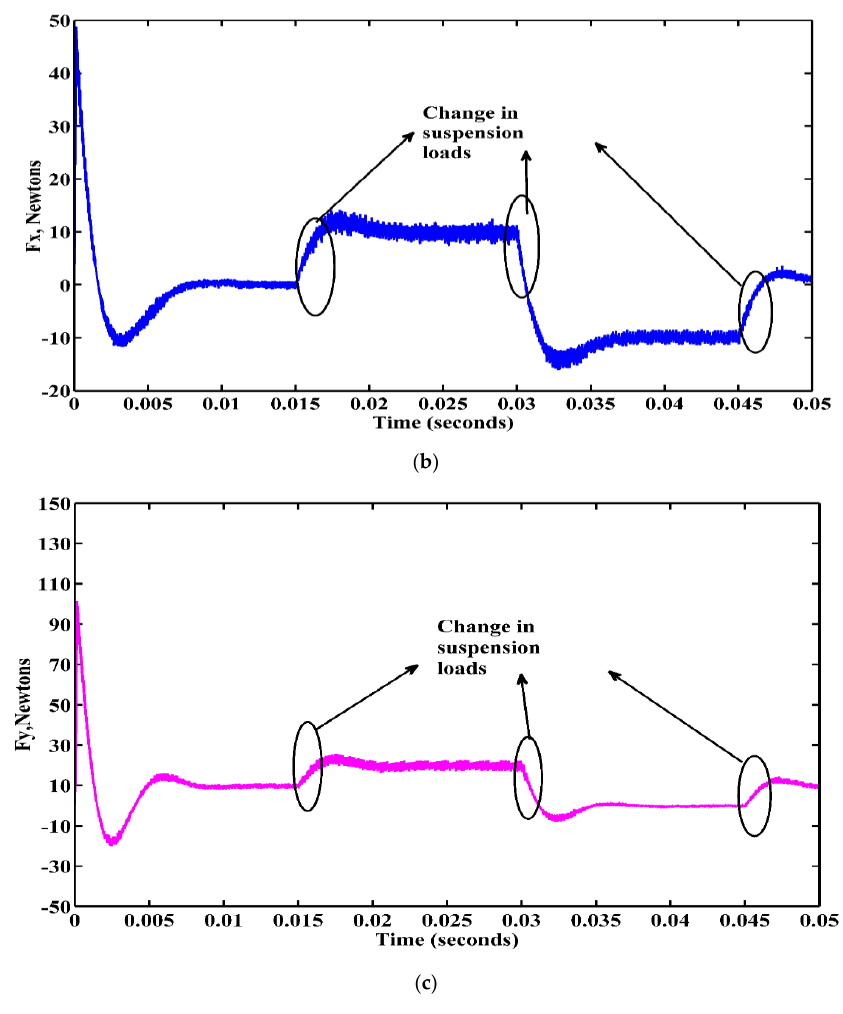
Figure 15. Third Quadrant suspension parameters. ( a ) Rotor Xand Y-axis dispalcements when suspension loads are applied; ( b ) Suspension force in the X direction when suspension loads are applied; ( c ) Suspension force in the Y direction when suspension loads are applied.